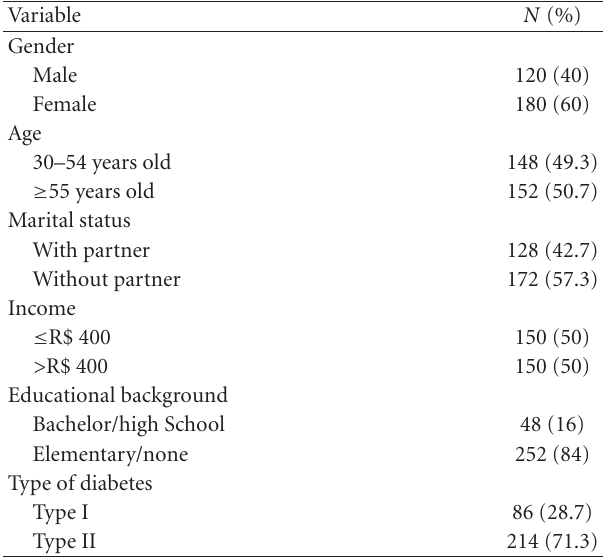
Table 2: Sample characterization. Belo Horizonte,